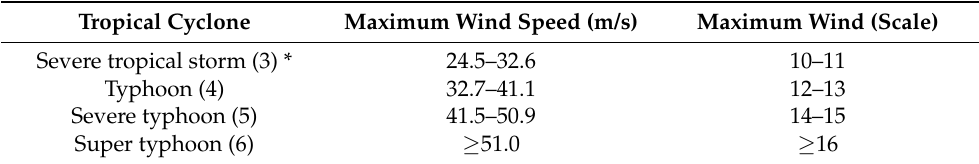
Table 1. Classification standard of typhoon disasters in Cangnan County.